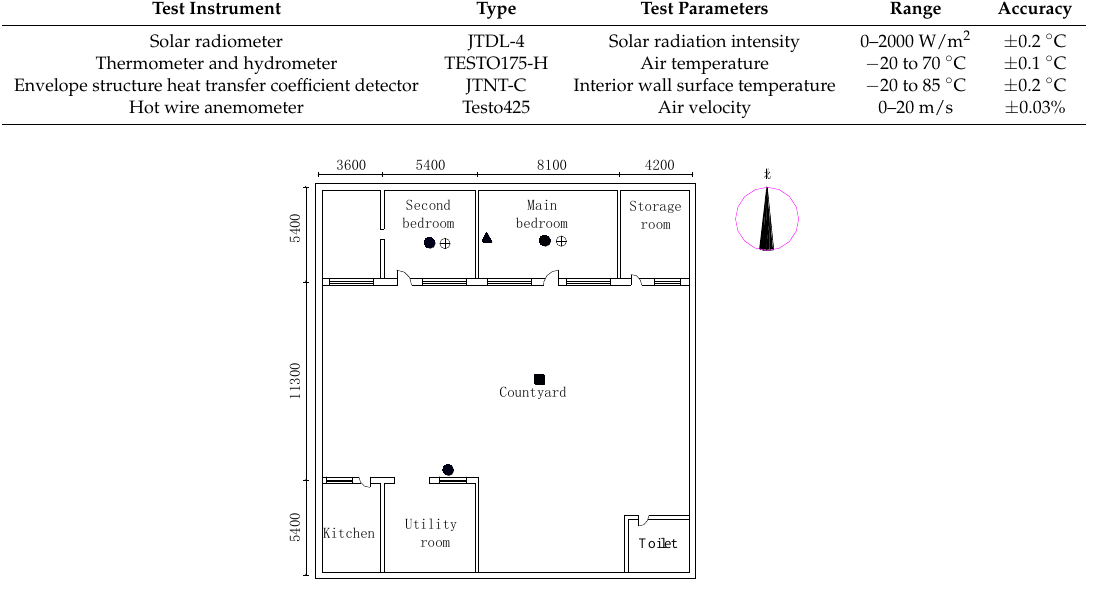
Figure 3. Layout of the residential building.